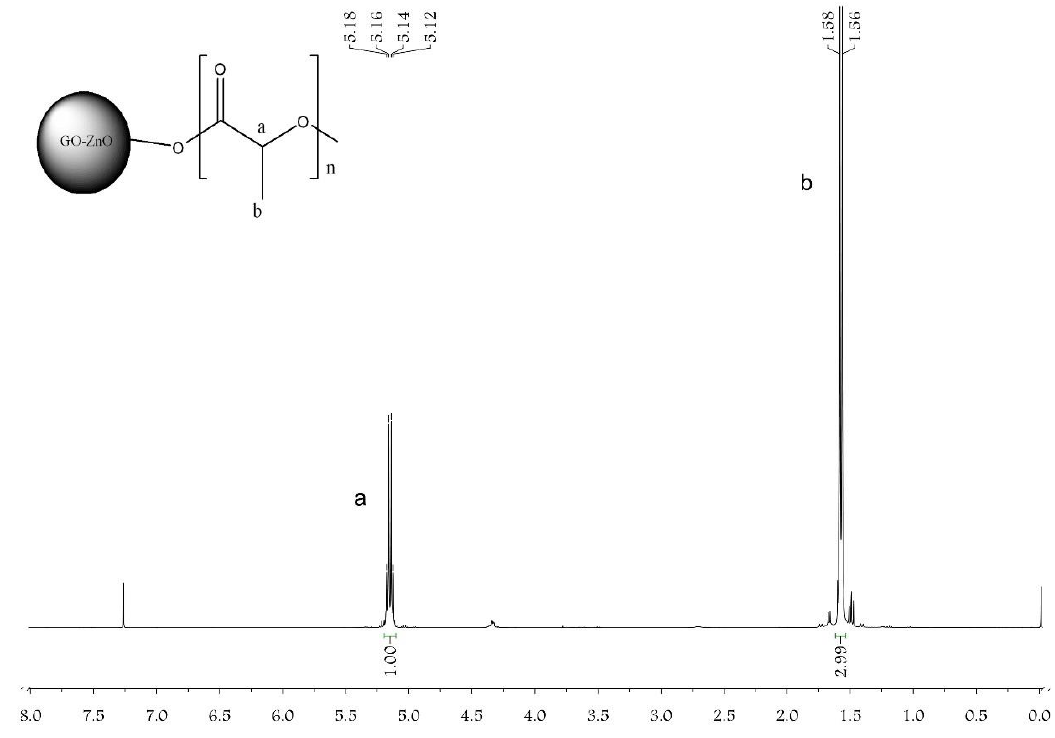
Figure 1. 400 MHz 1 H NMR spectrum of the GO-ZnO-PLLA sample.